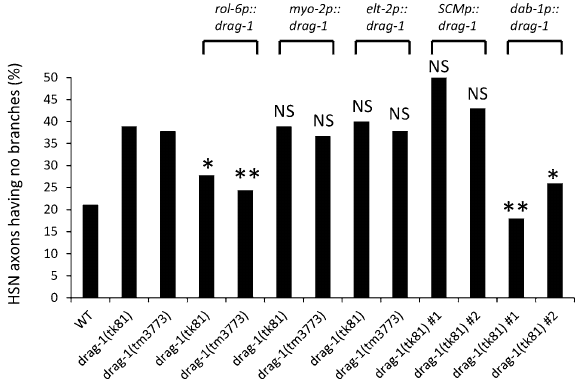
Figure 6. Tissue-specific rescue experiments of drag-1 mutants. Percentages of HSNs having no branches are shown. drag-1(tk81) and drag-1(tm3773) mutants were compared with those transgenic for rol-6p::drag-1 , myo- 2p::drag-1 , elt-2p::drag-1 , SCMp::drag-1 and dab-1p::drag-1 . Two independently isolated transgenic lines ( #1 and #2) were examined for each transgene. Significant differences were determined by Fisher’s exact test relative to